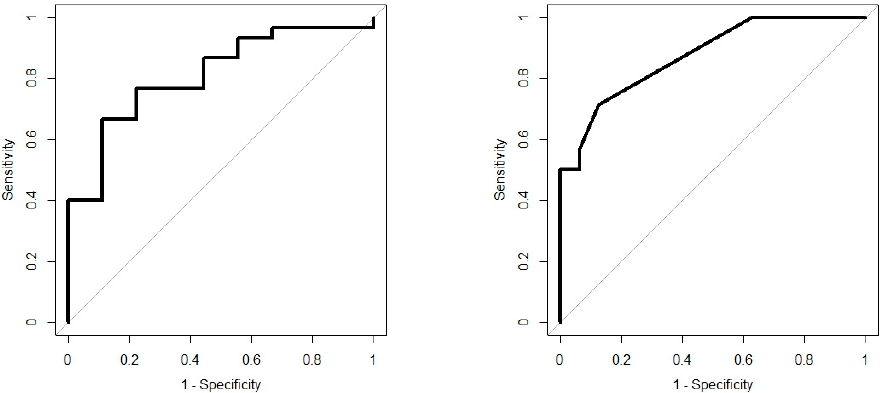
Figure 6. IBD analysis: G.A.S. BreathSpec GC-IMS ROC curves; IBD vs. Controls ( left ); CD vs. UC ( right ).